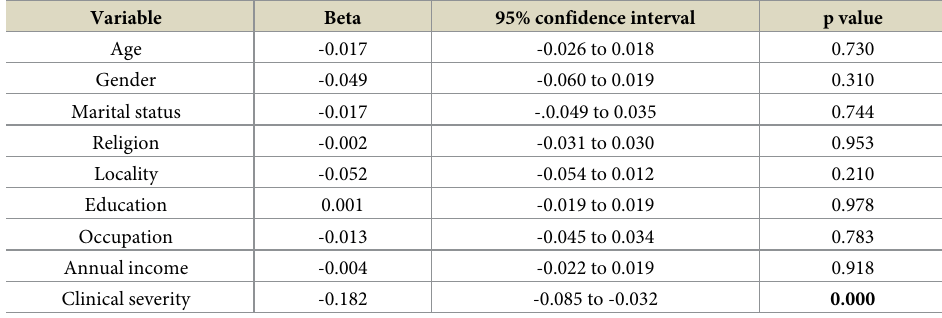
Table 2. Determinants of health related quality of life (EQ-5D-5L score) among RF/RHD patients.